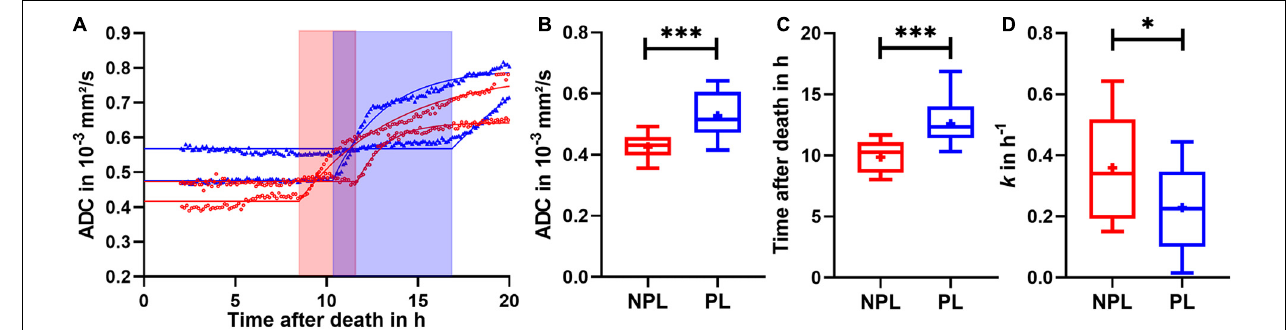
FIGURE 3 | (A) ADC data of two samples with the earliest and latest onset of ADC increase have been selected for illustration, separately for NPLs (red) and PLs (blue). Solid lines represent fitted curves using the exponential model. Colored blocks indicate the time duration of the observed ADC increase. Box plots of (B) ADC 0 -initial fitted ADC values in mm 2 /s (C) onset time of the ADC increase in hour and (D) k -rate constant in h − 1 . Data are presented as minimum to maximum with interquartile range and median; + indicates means. ∗ p ≤ 0.05; ∗∗∗ p ≤ 0.001. NPL, non-perfused liver; PL, perfused liver.